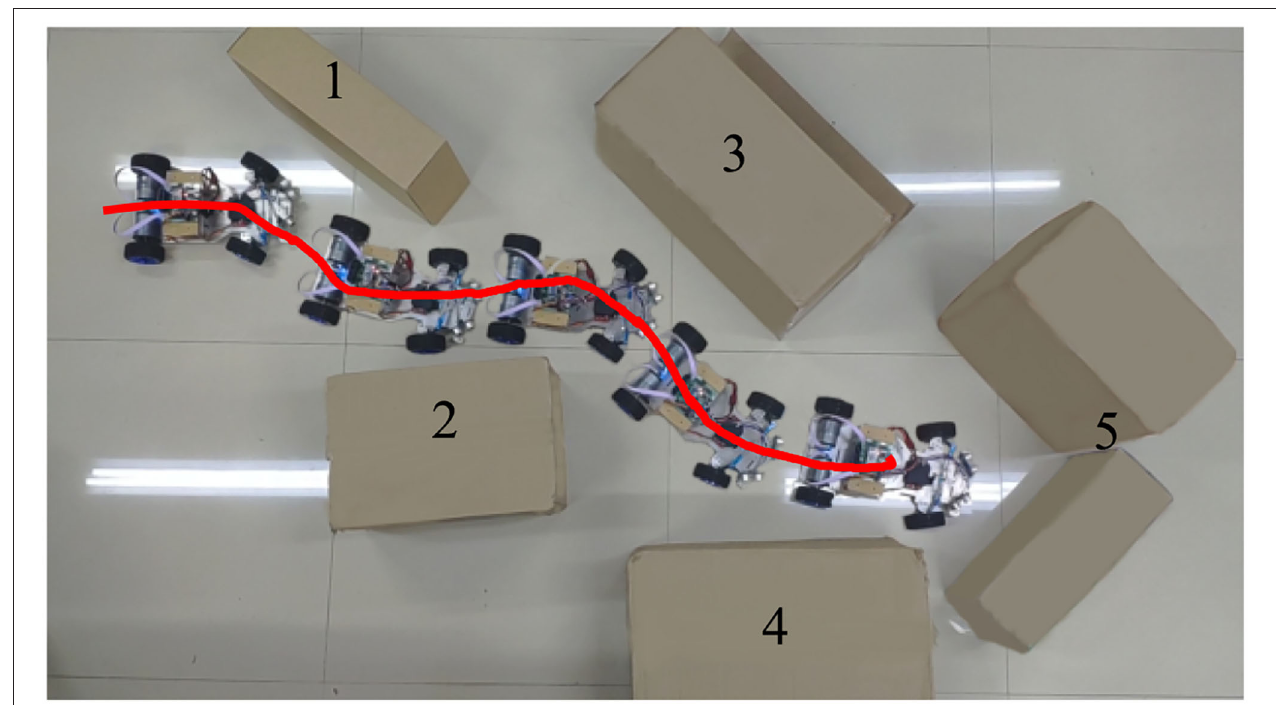
FIGURE 9 | The travel route of the mobile robot when avoiding